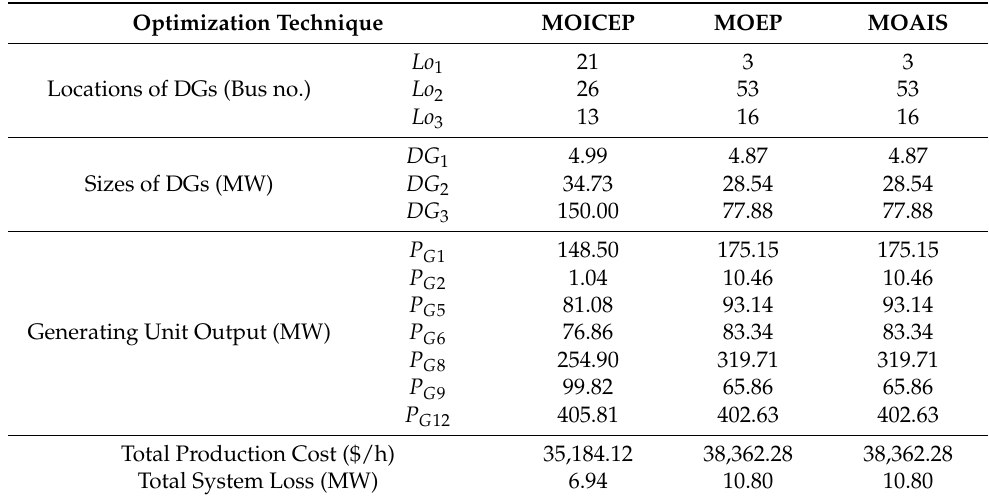
Table 15. Results of the integrated ED problem with prohibited operating zones and DG installation of the IEEE 57-Bus RTS ( w 1 = 0.1 and w 2 = 0.9). Optimization Technique MOICEP MOEP MOAIS Lo 1 Locations of DGs (Bus no.)